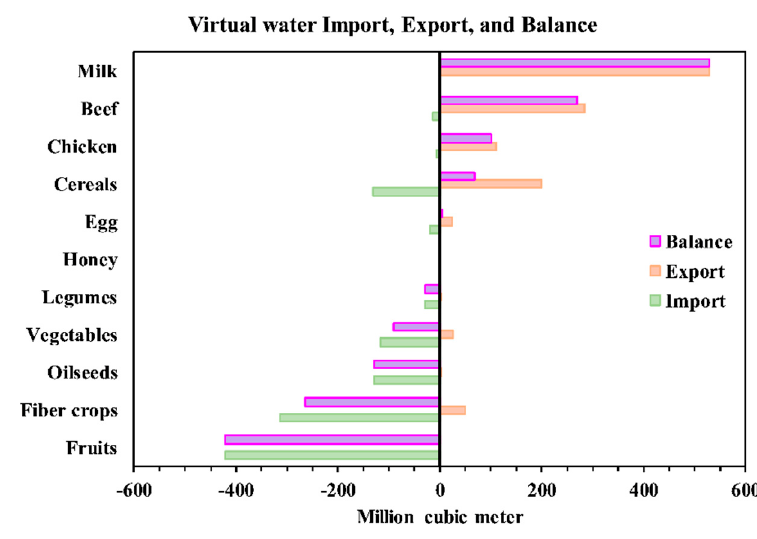
Figure 4. Virtual water import, export, and balance in agricultural products.